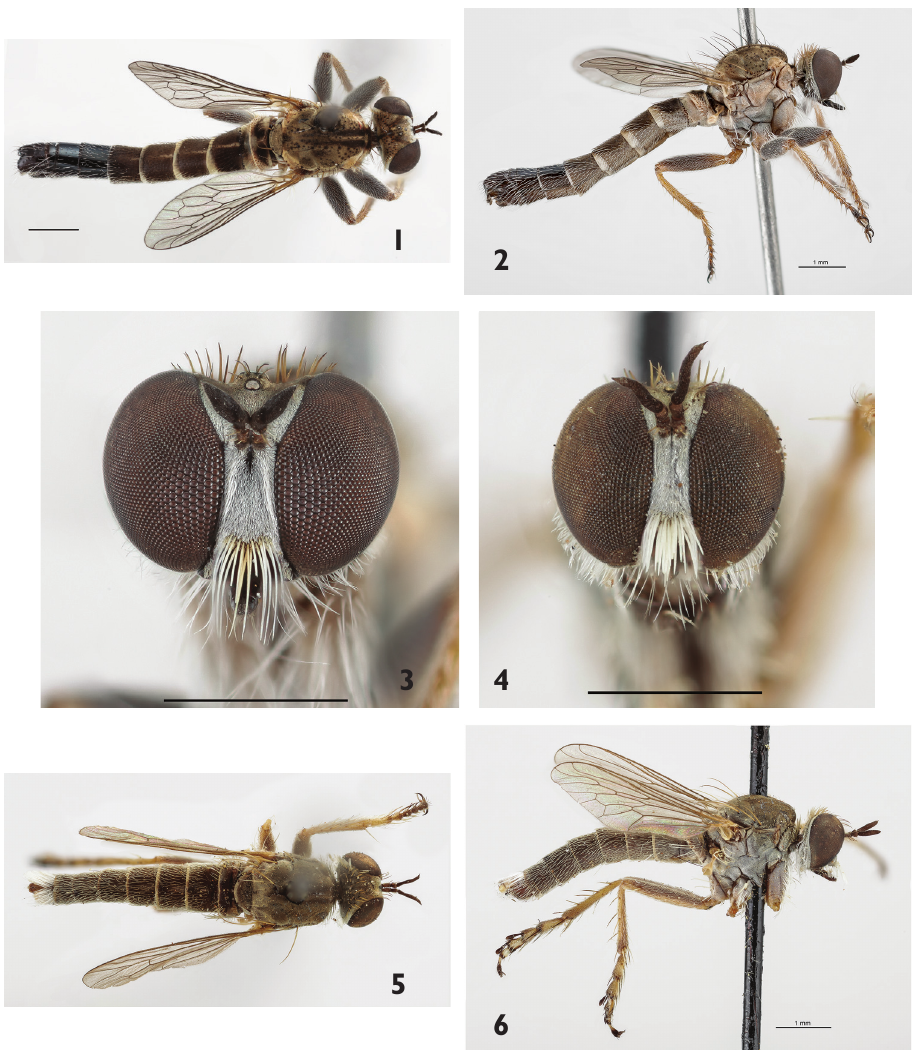
Figures 1–6. Photographs of Trichoura : 1 male T. tankwa (USNMENT01115152), dorsal (Morph- bank #860636) 2 same, lateral (#860638) 3 same, head anterior (#860640) 4 male T. torynopoda (USN- MENT01295405) head anterior (#860659) 5 same, dorsal (#860655) 6 same, lateral (#860657). Scale bars: 1 mm.